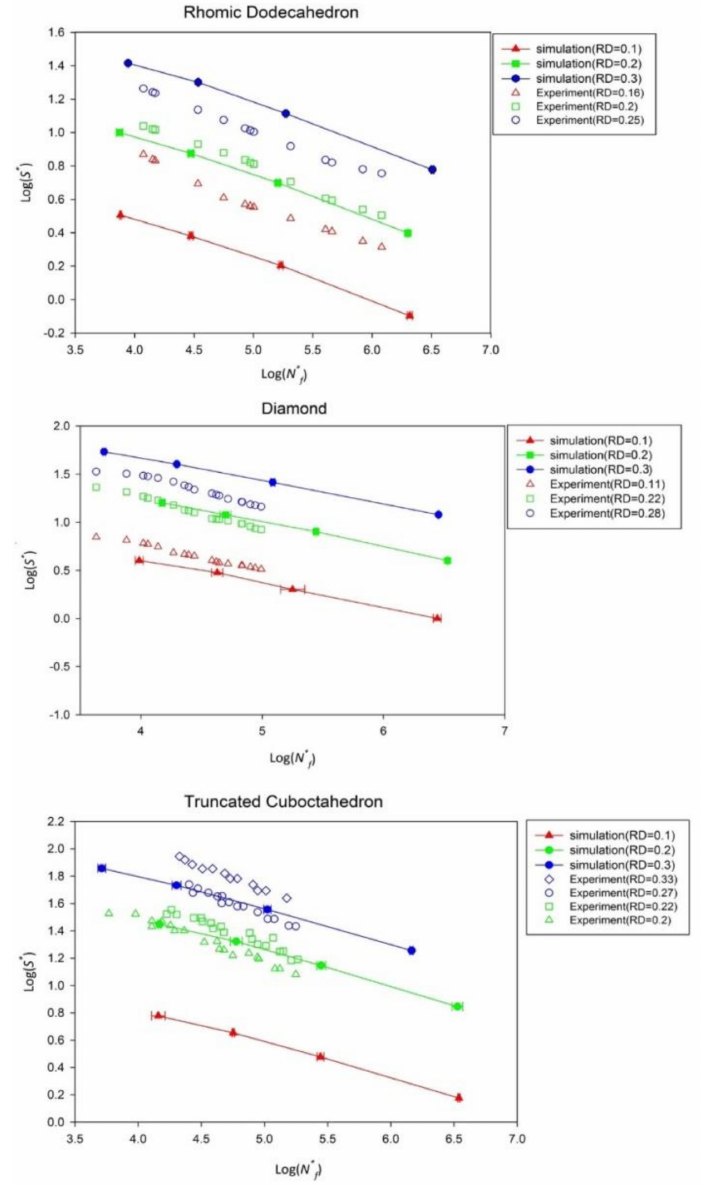
Figure 9. S − N curves of titanium scaffolds with various relative densities compared to experimental results for the rhombic dodecahedron, diamond, and truncated cuboctahedron structures. Reprinted with permission from ref. [57]. 2015,